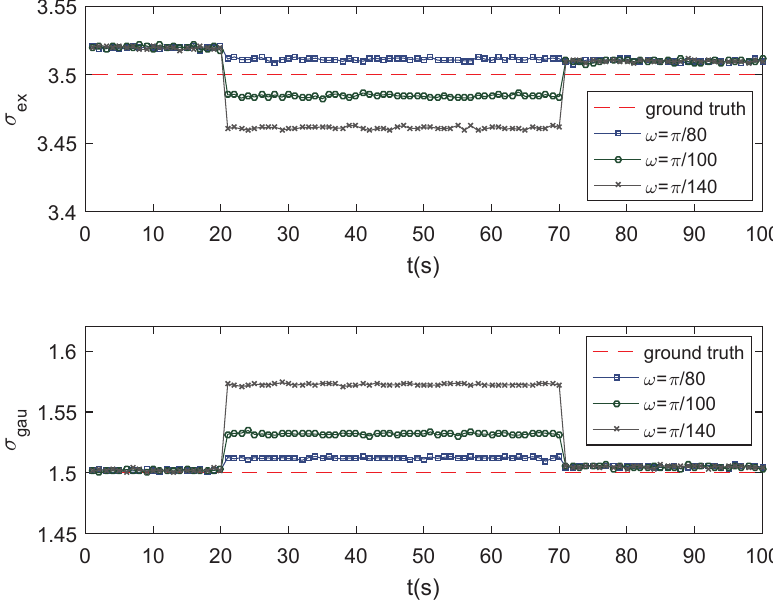
Figure 8. Estimation of σ ex and σ gau with a different turn rate.